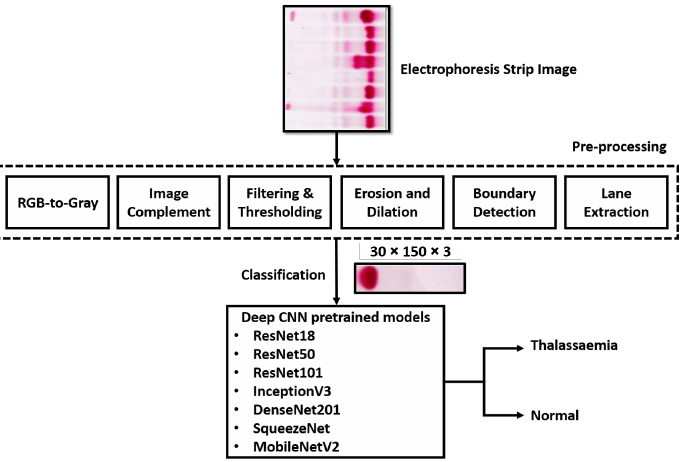
Figure 3. Overview of the complete methodology used in this